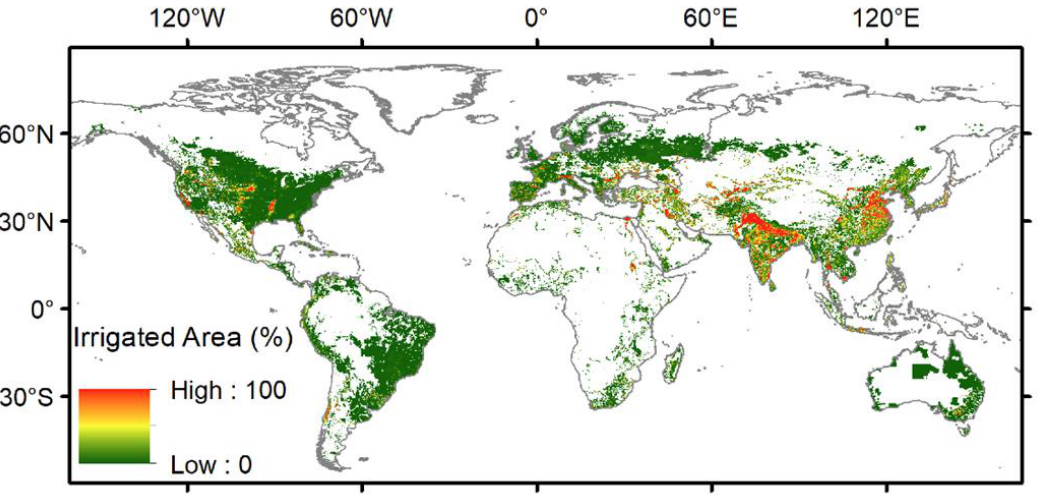
Figure A3 . Global map of irrigated areas provided by the Food and Agricultural Organization [133] .